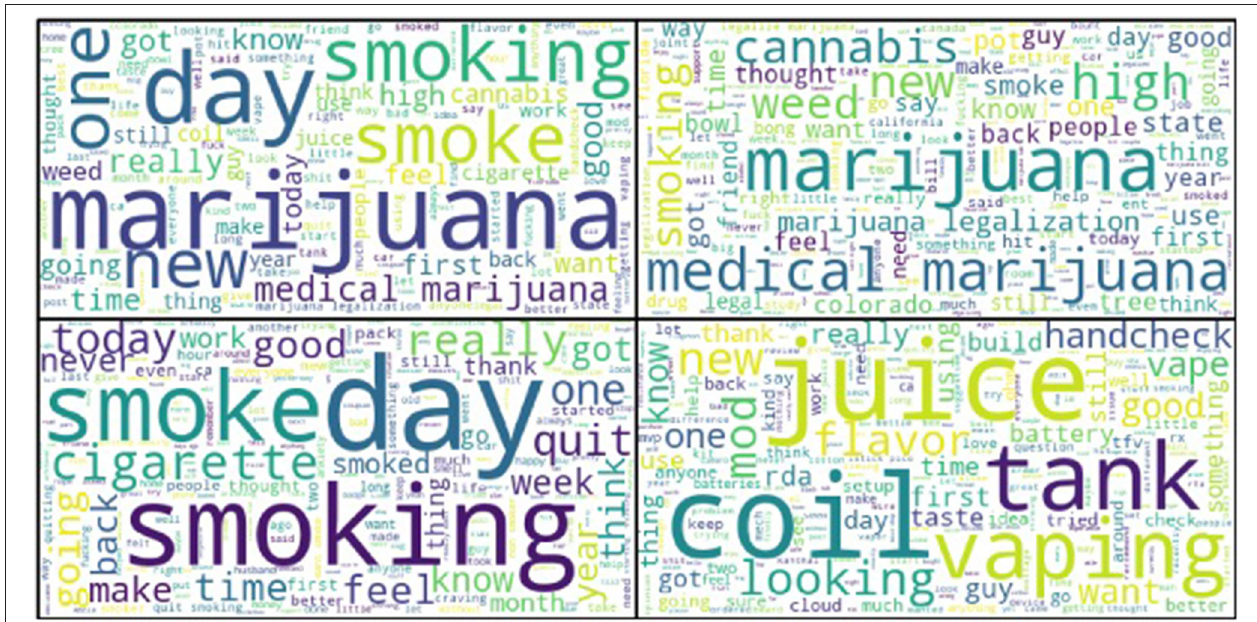
FIGURE 5 | Word cloud representations of our annotated corpus of 2,148 Reddit posts. Top left: all posts, top right: cannabis-related posts, bottom left: tobacco-related posts, bottom right: ENDS-related posts.